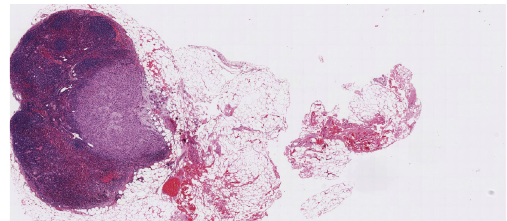
Figure 4: Tissue sample. Two millimetres lymph node metastasis with extracapsular